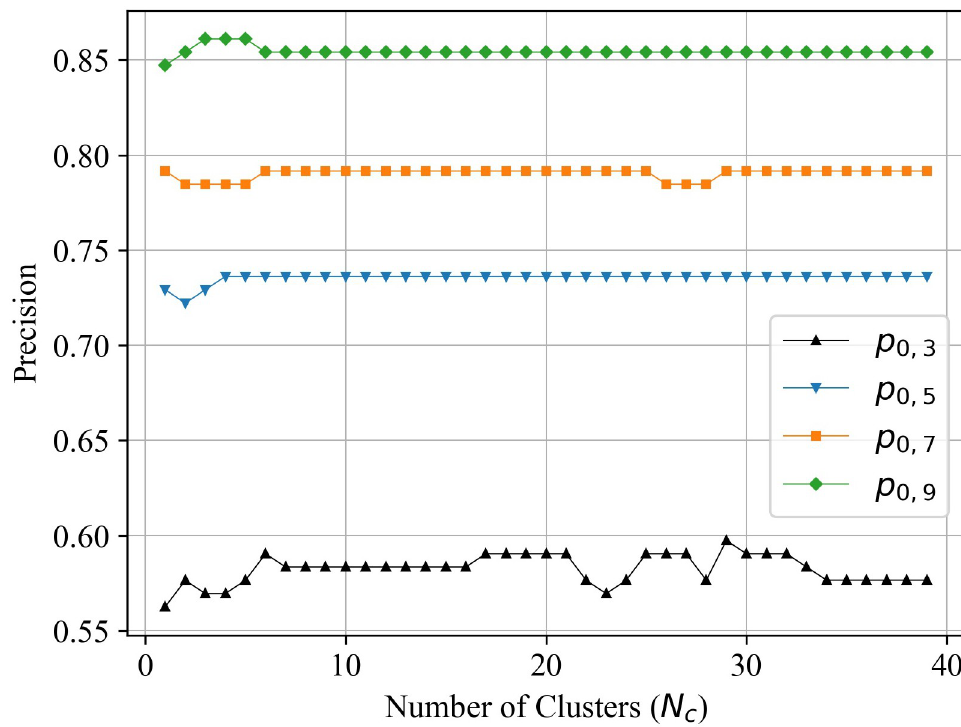
Fig 4. The precision within each error range versus N c .